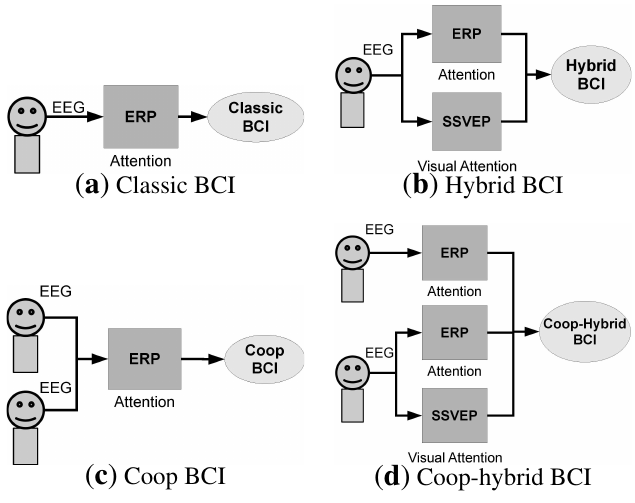
Figure 1. Examples of different BCI